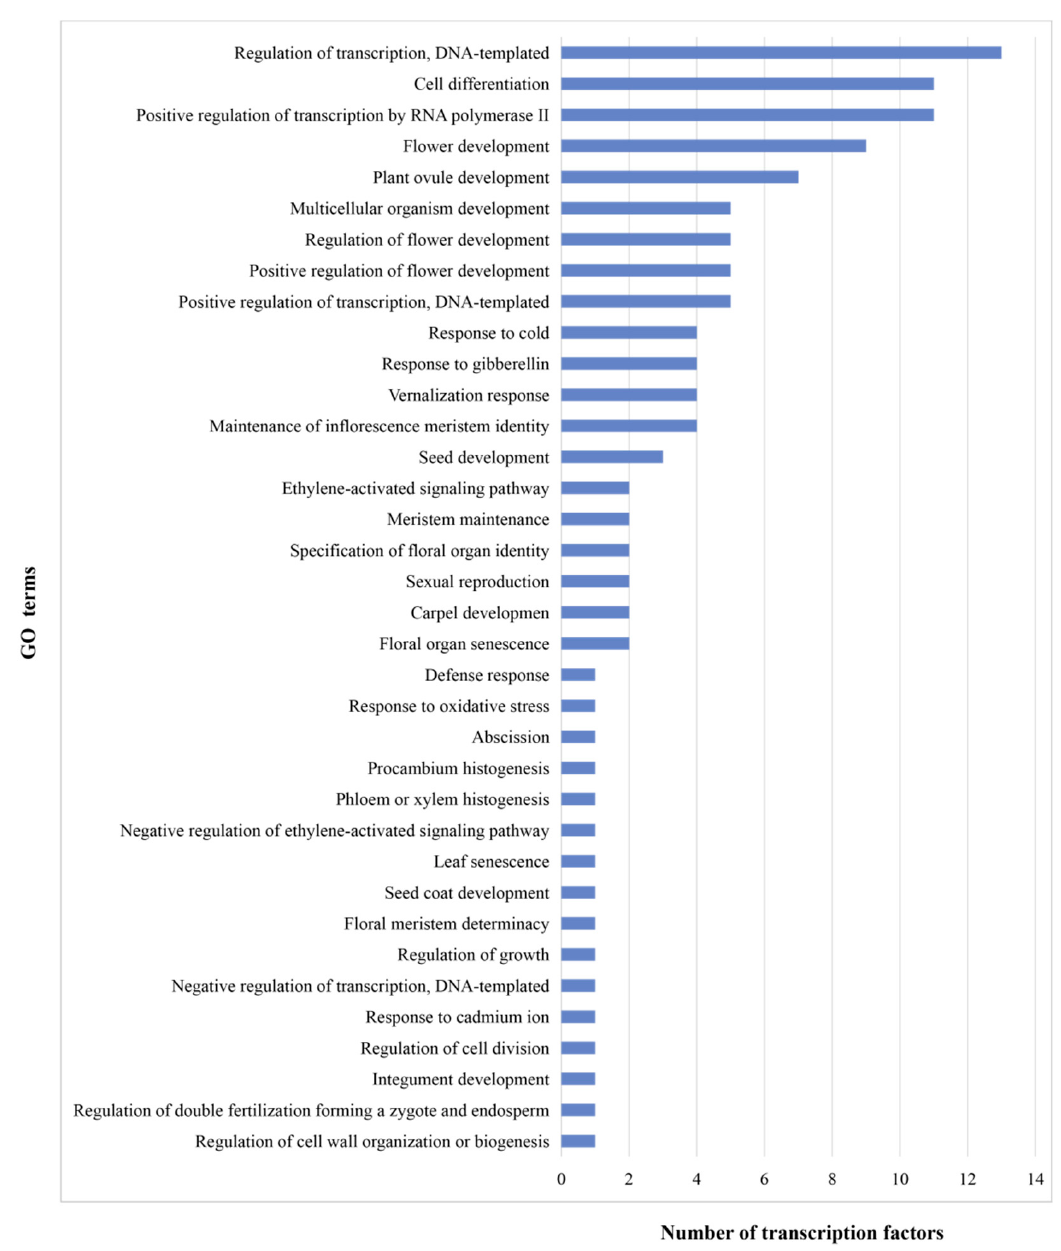
Figure 2. Biological processes in Gene Ontology (GO) terms. Based on the results of blast analysis, the GO terms associated with the Arabidopsis thaliana homologs were assigned to the Larix kaempferi transcription factors.